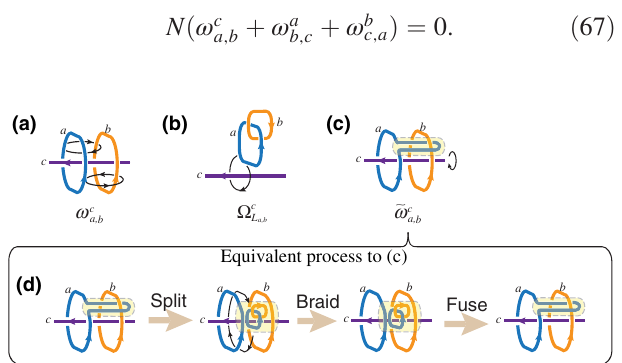
and Σ that are I J FIG. 15. Three different string braiding processes, named (a) the string-string braiding, (b) the link-string braiding, and and Σ have I J (c) the linked braiding. As is explained in the main text, the Berry ’ s phases associated with these three processes are identical. and Σ that I J (d) The decomposed steps that relate processes in (c) and